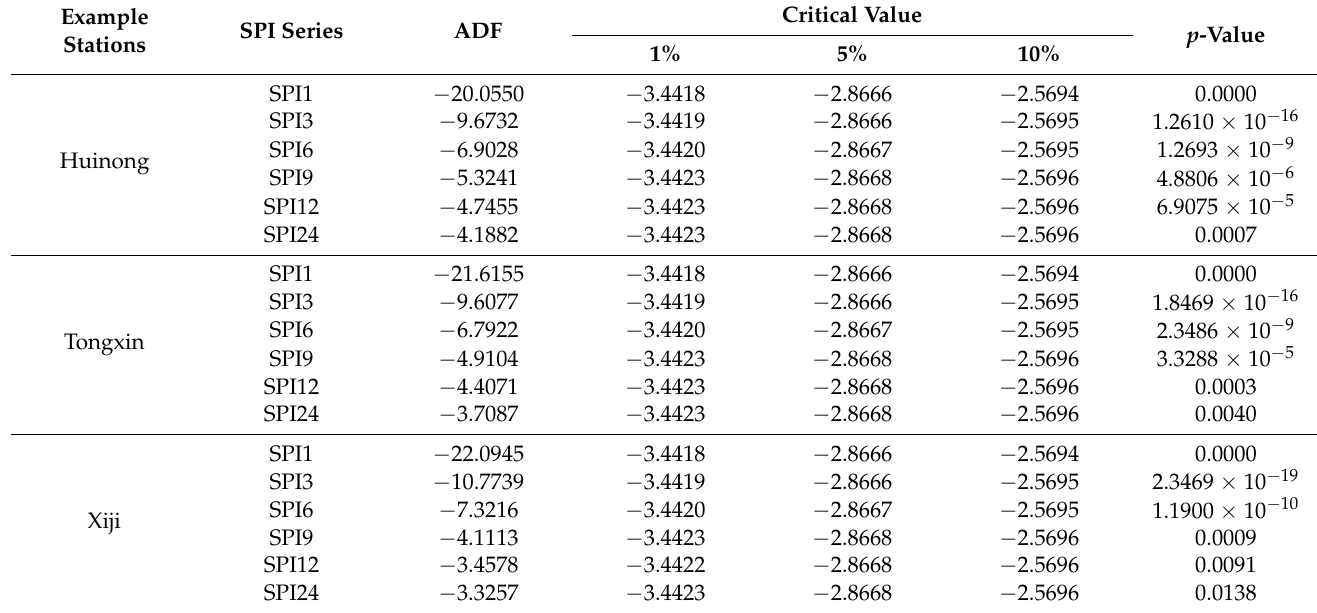
Table 3. Unit root test of SPI original sequence.